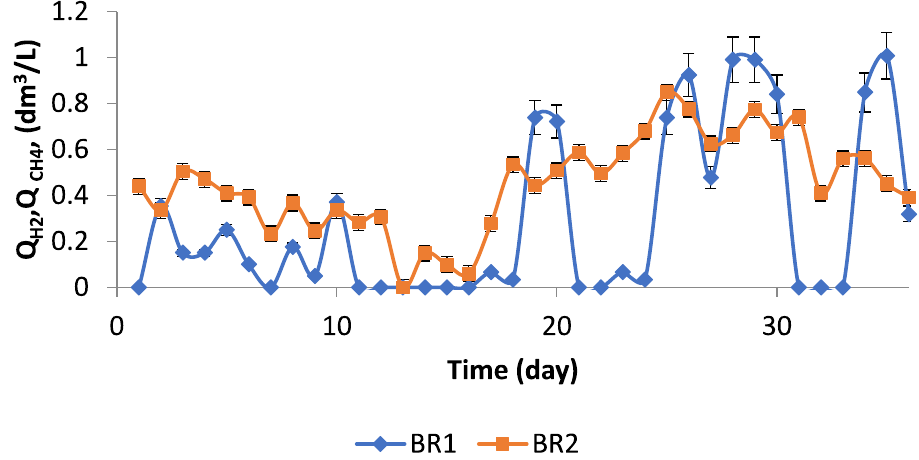
Figure 7. Biogas yields in BR 1 and in BR 2 in continuous mode of TPAD of